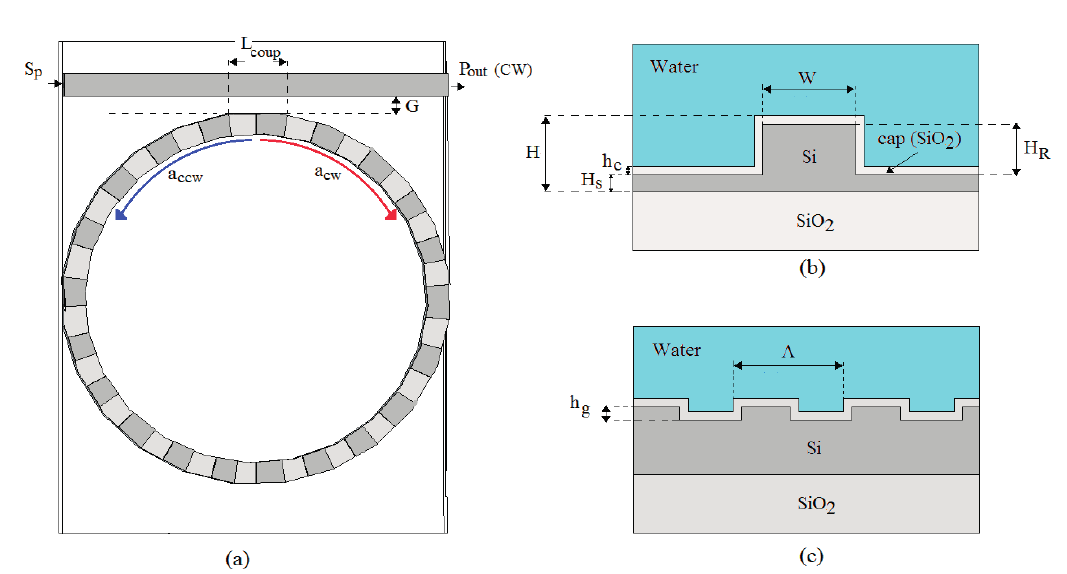
external waveguides; ( b ) Silicon on Insulator (SOI) waveguide cross-section; ( c ) Bragg grating